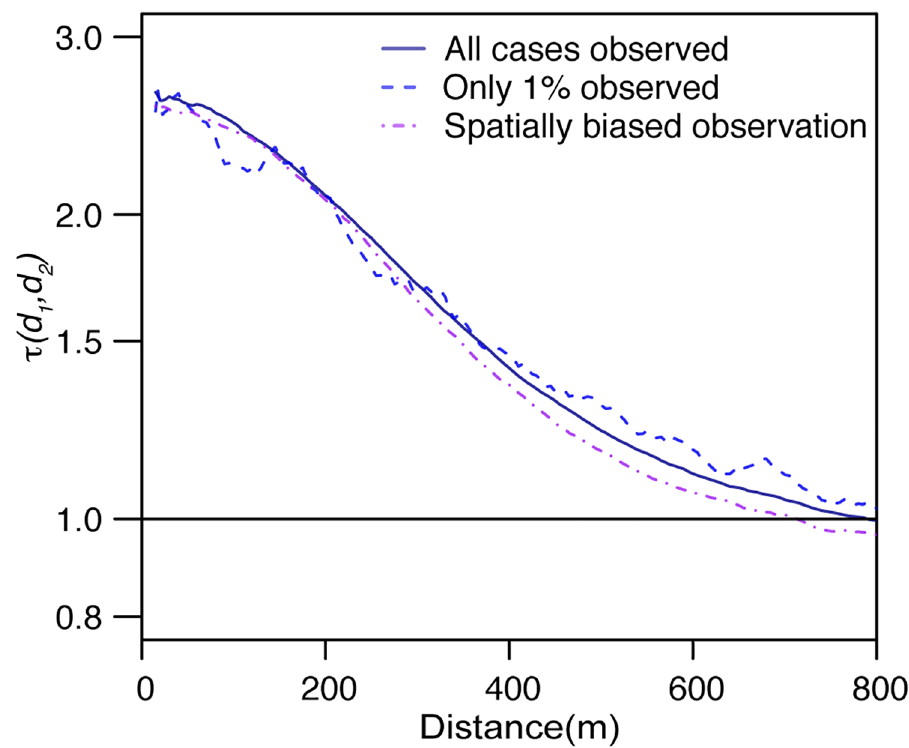
Fig 3. Performance of the τ -statistic under different observation scenarios: complete observation (blue solid line), spatially random observation (dashed blue line) and spatially biased observation (purple line). For the spatially random observation all cases had a 1% probability of being observed. For the partially observed observation, the probability of observation was 0.1xexp(- d ), where d was the distance (in km) to the closest ‘ surveillance hospital ’ in the area (marked by two black dots in Fig 2A).